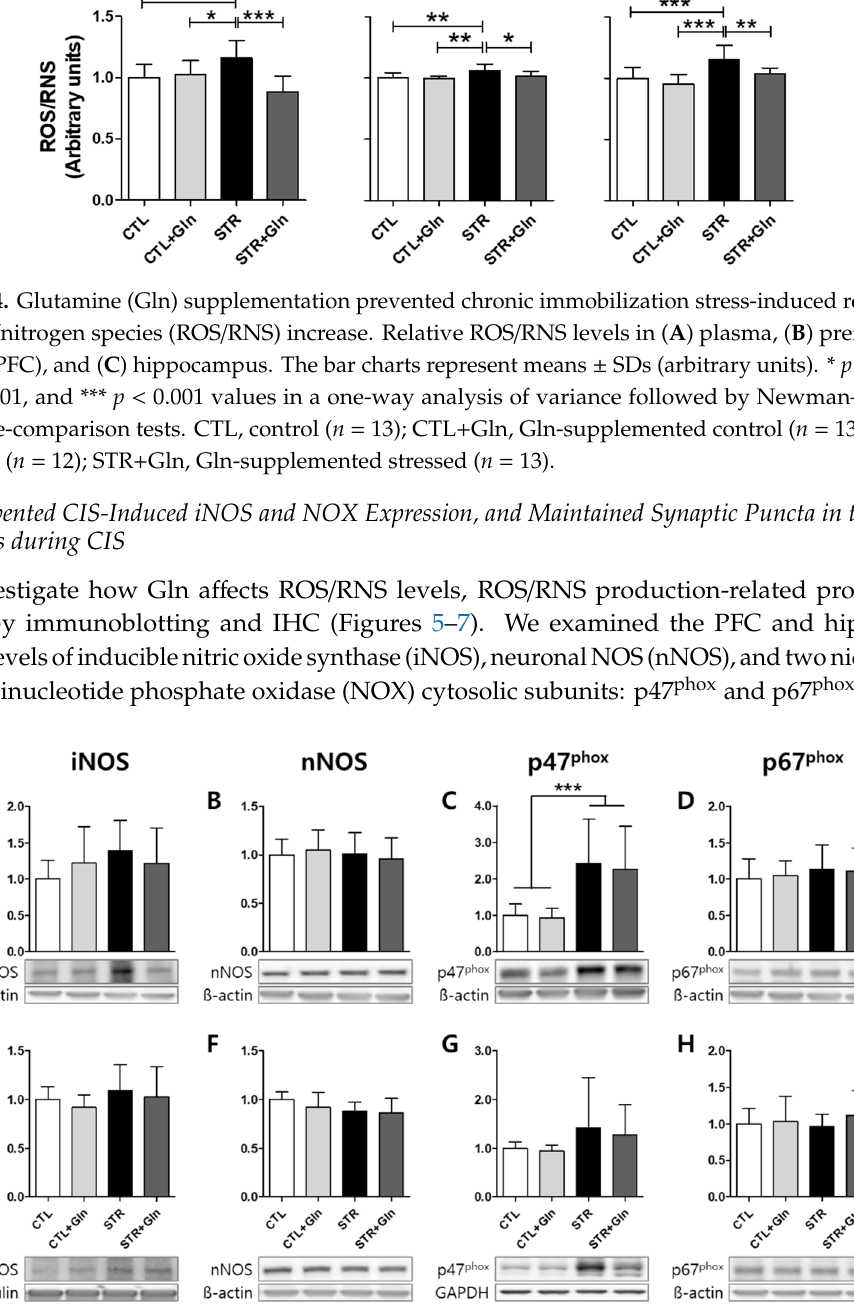
Figure 5. Protein expression changes related to reactive oxygen / nitrogen species (ROS / RNS) evaluated by immunoblotting. ( A – D ) Prefrontal cortex (PFC) and ( E – H ) hippocampus. The bar charts represent means ± SDs (arbitrary units). *** p < 0.001 value in a one-way analysis of variance followed by Newman–Keuls multiple-comparison tests. CTL, control ( n = 13); CTL + Gln, Gln-supplemented control ( n = 13); iNOS, inducible nitric oxide synthase; nNOS, neuronal NOS; p47 phox and p67 phox are NADPH oxidase cytosolic subunits; STR, stressed ( n = 12); STR + Gln, Gln-supplemented stressed ( n =